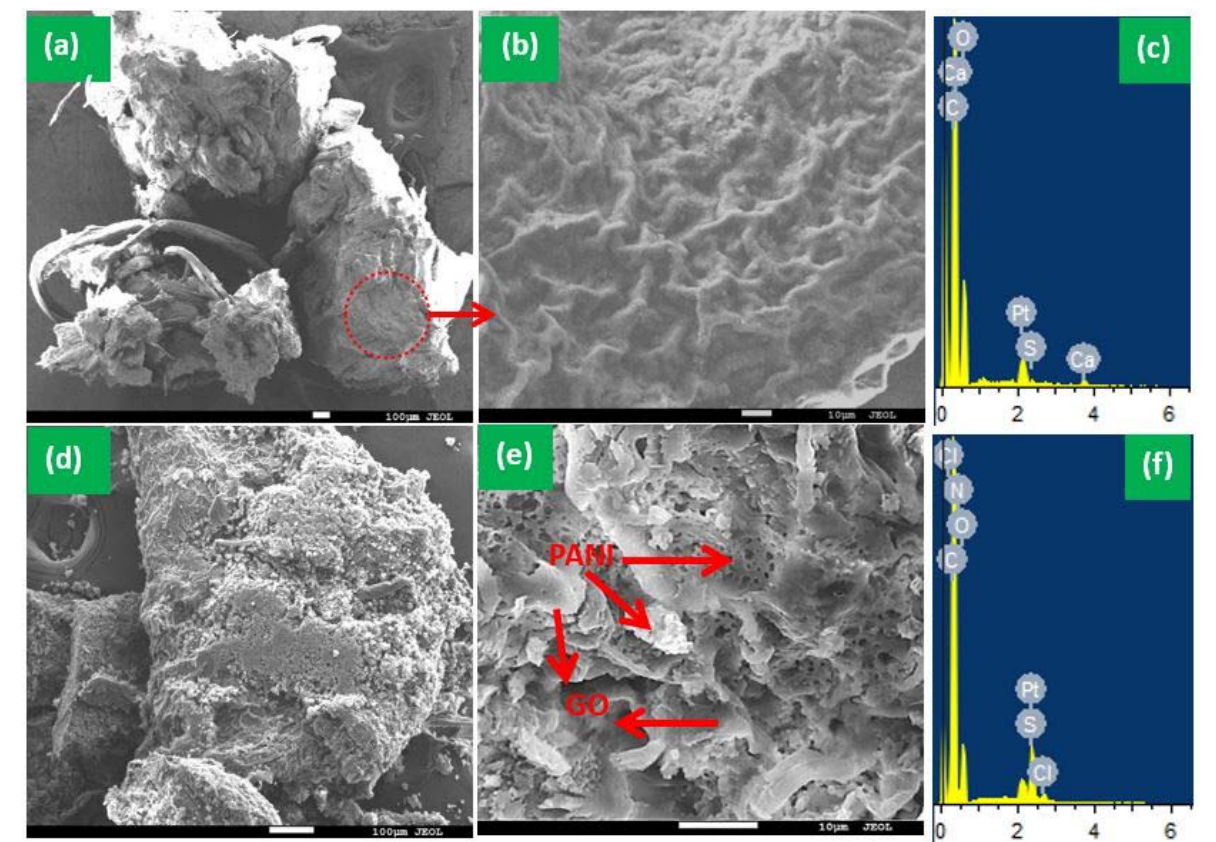
Figure 3. SEM images and EDX analysis of ( a – c ) granular tea waste and ( d – f ) PANI/GO/@GTW. The identification of elemental compositions and their oxidation states was done using the XPS technique. The wide scan survey of the PANI/GO@GTW composite is shown in Figure 4a, indicating the presence of the C—75.7%, O—15.4%, N—7.6 %, and S—1.2 % for the C1s, O1s, N1s, and S2s, respectively. The deconvolution of the C1s (Fig ‐ ure 4b) indicates the presence of the C ‐ C (184.33 eV), C ‐ N/C = N (286.12 eV), and C = O (289.14 eV) groups which belong to the GO, PANI, and GTW [30]. Figure 4c indicates that several peaks for the deconvoluted N1s correspond to N + (401.7 eV), and NH + (403.1 eV) [31]. The XPS spectra of O1s showed the two peaks at 529.68 eV and 531.8 eV, indicating the presence of C ‐ O and C = O related groups in the GO and GTW as shown in figure 4d [32]. The XPS analysis confirmed the surface elements of the PANI/GO@GTW composite that are present in the synthesized material.